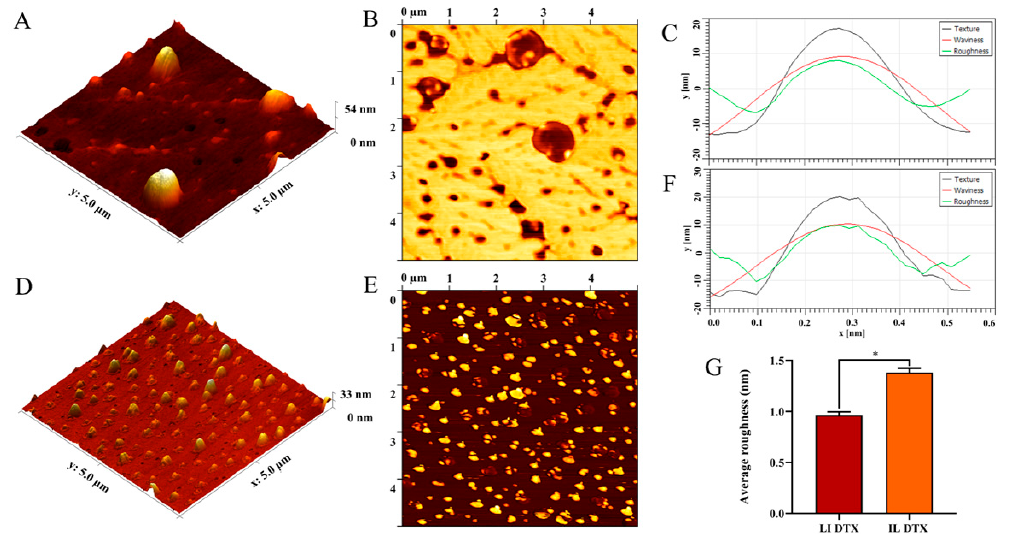
Figure 6. Image of the morphology of the liposome with drug ( A , B ), immunoliposome with drug ( D , E ), histograms of roughness of the liposome with drug ( C ), histograms of the roughness of the immunoliposome with drug ( F ), graph of mean roughness of liposome and immunoliposome DTX ( G ). * p < 0.05.